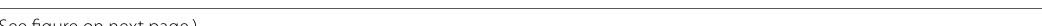
tional file 6: Fig. 6, Additional file 7: Fig. 7).